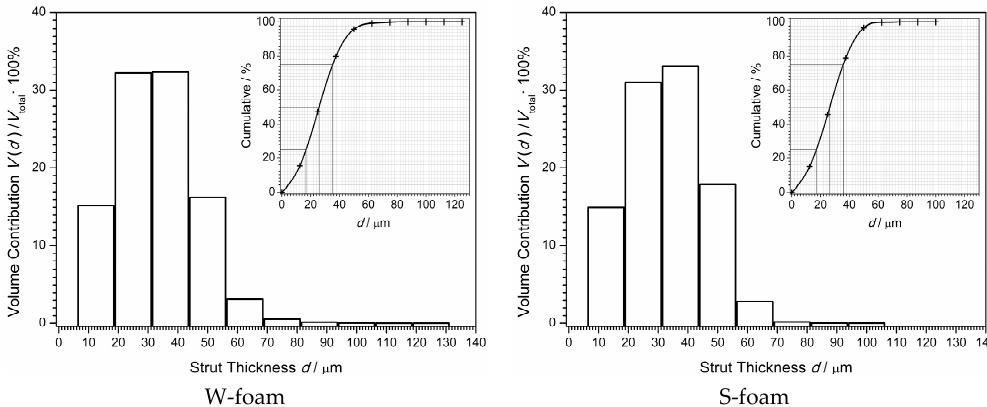
Figure 5. The volumetric strut (thickness) distribution for both the W- and S-foam (BMP not resized, image pixel size 6.25 µm).